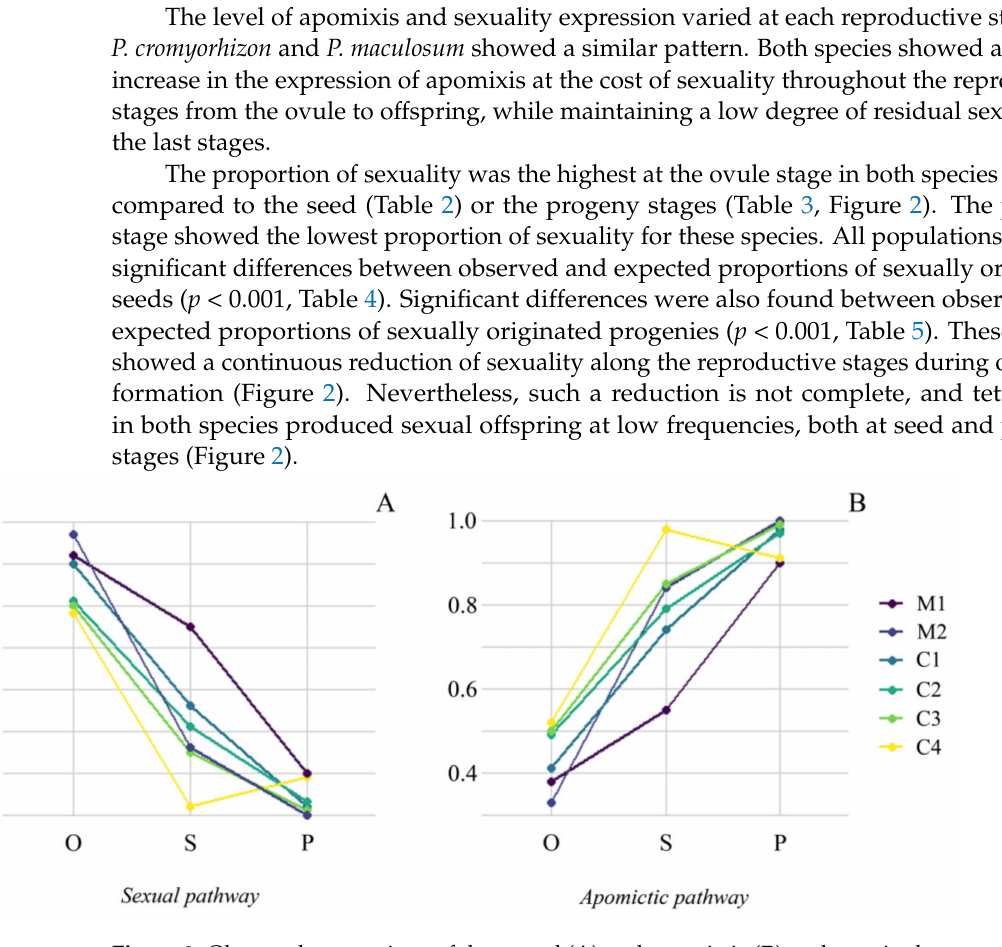
Figure 2. Observed proportions of the sexual ( A ) and apomictic ( B ) pathway in three reproductive stages: ovules (O), seeds (S), and progeny (P) in P. maculosum and P. cromyorhizon